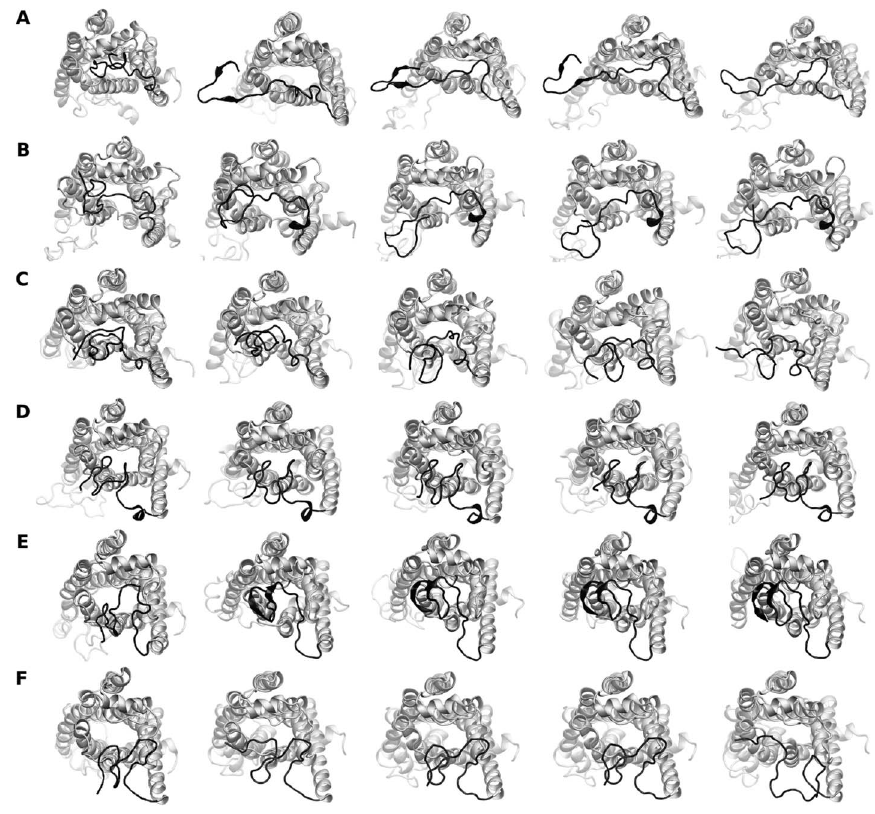
Fig. 3. Top-view snapshots of the Arg and Gly variants of b 2 AR during the course of the simulation. The snapshots are shown at time intervals of 250 ns. Panel A, B and C represent simulation number 1, 2 and 3 of the Arg variant and panel D, E and F represent simulation number 1, 2 and 3 of the Gly variant, respectively. The protein is rendered as ribbons and the N-terminal residues are colored black.